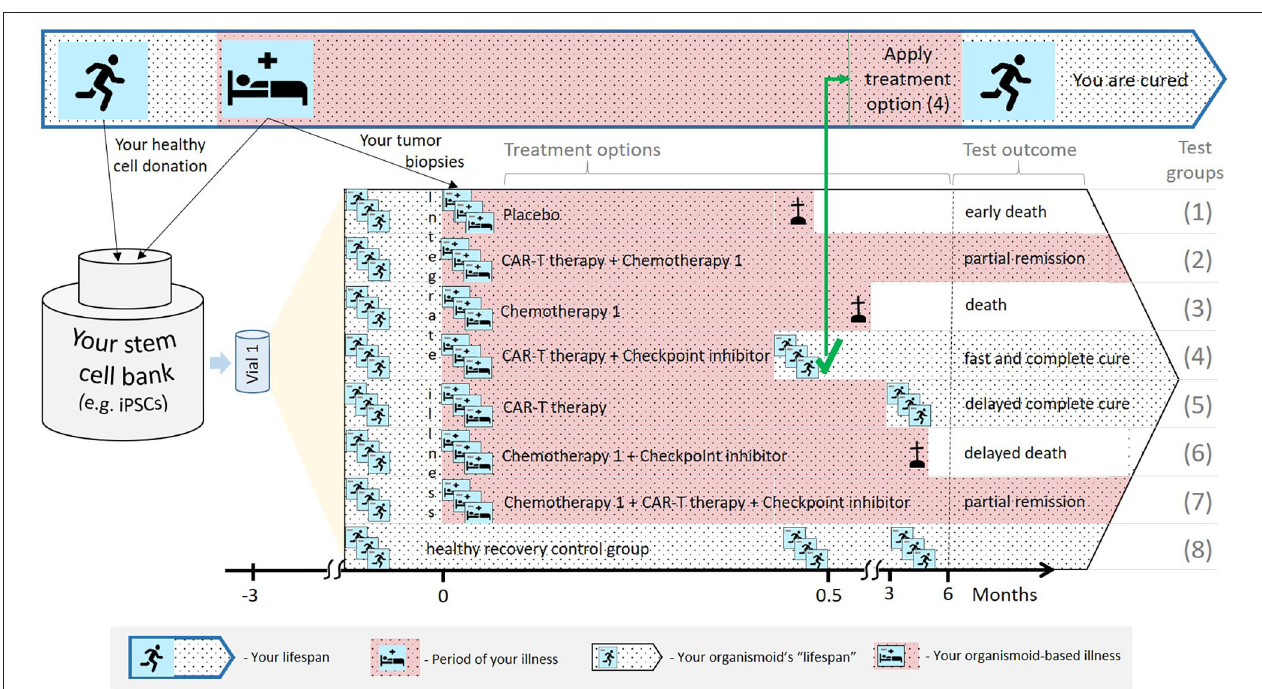
FIGURE 5 | A hypothetical example illustrating how the organismoid theory can be utilized in personalized medicine.